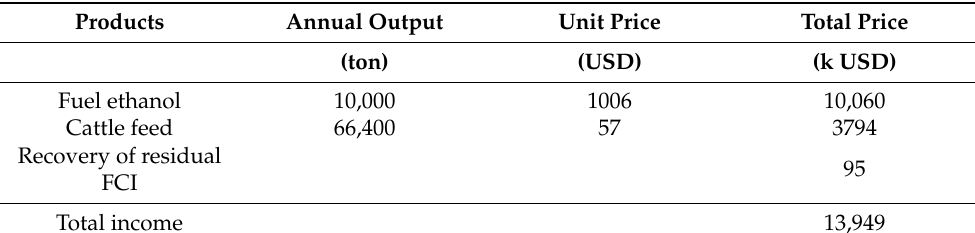
Table 5. Operating income of OPTS 10,000 tons fuel ethanol per year project.